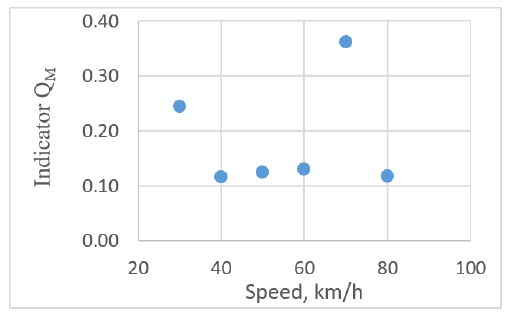
Figure 14. Values of Q M , considering the maximal forces when unloaded goods wagon.